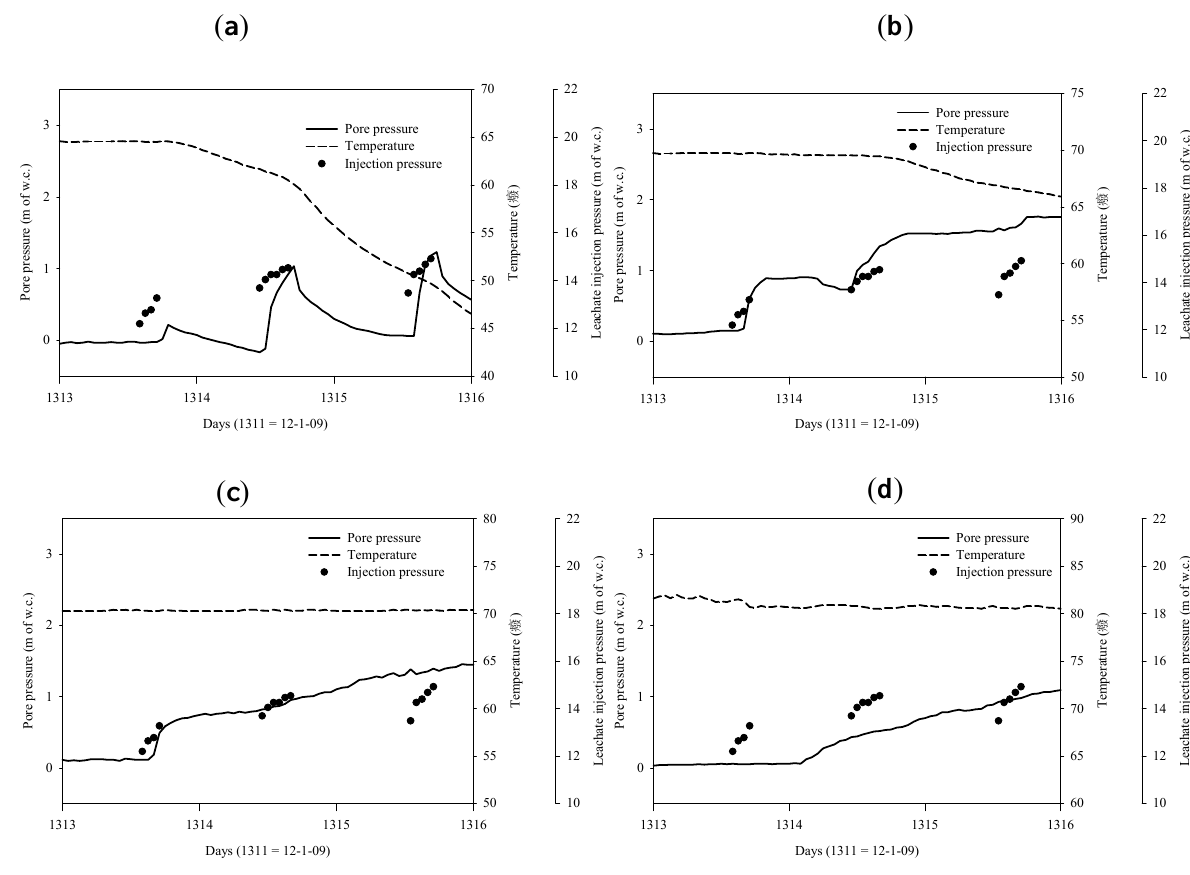
Figure 4. Piezometer responses to leachate recirculation at various depths and at a fixed radial distance of 1.5 m from the well during the first few days of operation at an average flow rate of 1.4 × 10 − 3 m 3 /sec. ( a ) Piezometers at a depth of 5.8 m from the surface of the landfill; ( b ) Piezometers at a depth of 8.8 m from the surface of the landfill; ( c ) Piezometers at a depth of 11.9 m from the surface of the landfill; ( d ) Piezometers at a depth of 18 m from surface of the